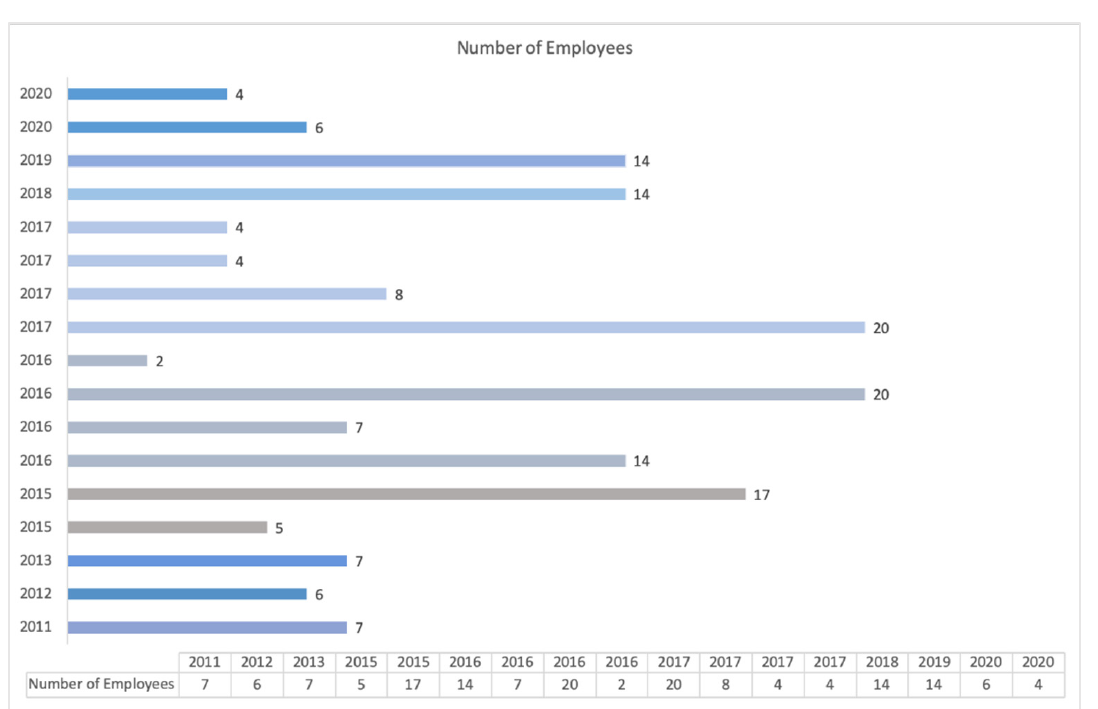
Figure 4. Sample Characteristics. Source: own data.